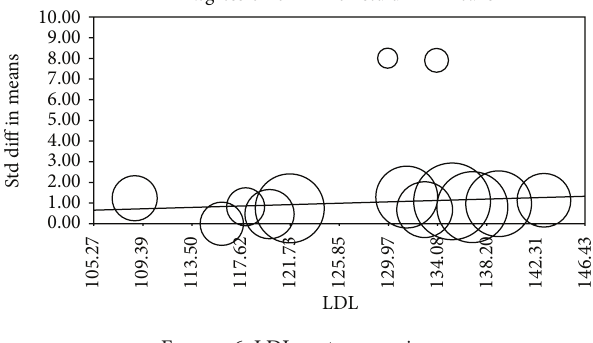
Figure 6: LDL metaregression.